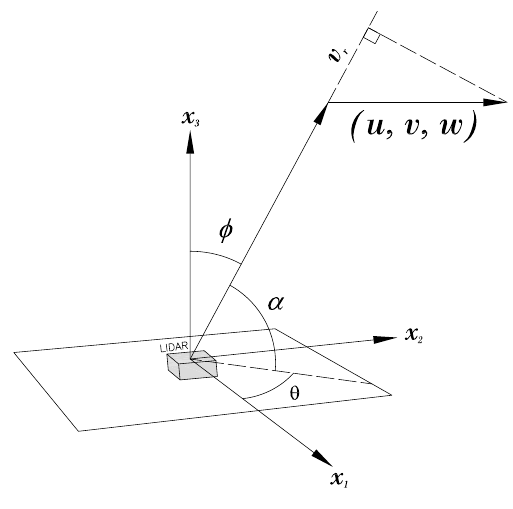
Figure 1. Coordinate system of a